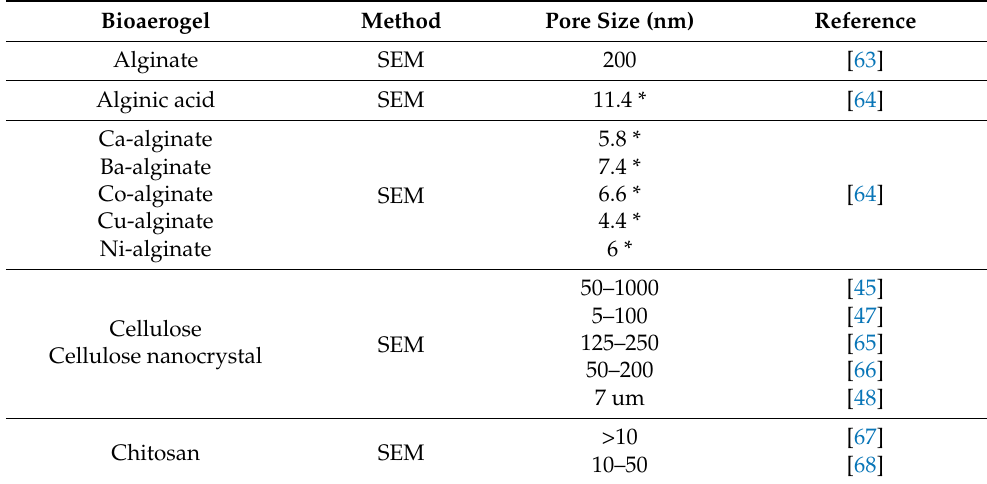
Table 2. Reported pore size or pore size distribution of some bioaerogels, obtained by scanning electron